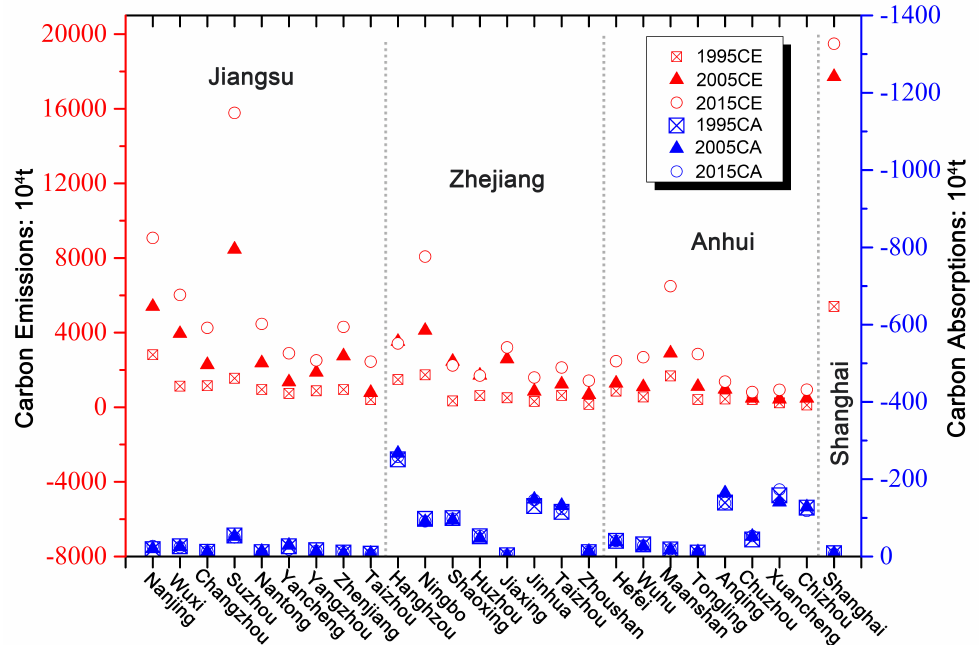
Figure 4. Land-use specific carbon emissions (CE) and carbon absorptions (CA) of the 26 YRDUA cities in 1995, 2005, and 2015.